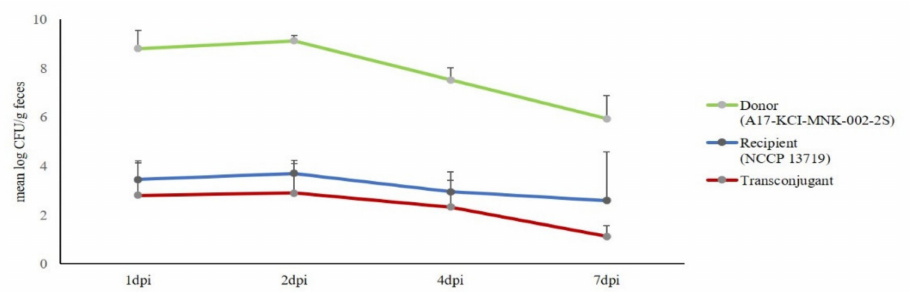
Figure 2. Bacterial counts of the donor, recipient, and transconjugant from mouse fecal samples in group 4 (G4), expressed as the log number of CFU per gram of feces.